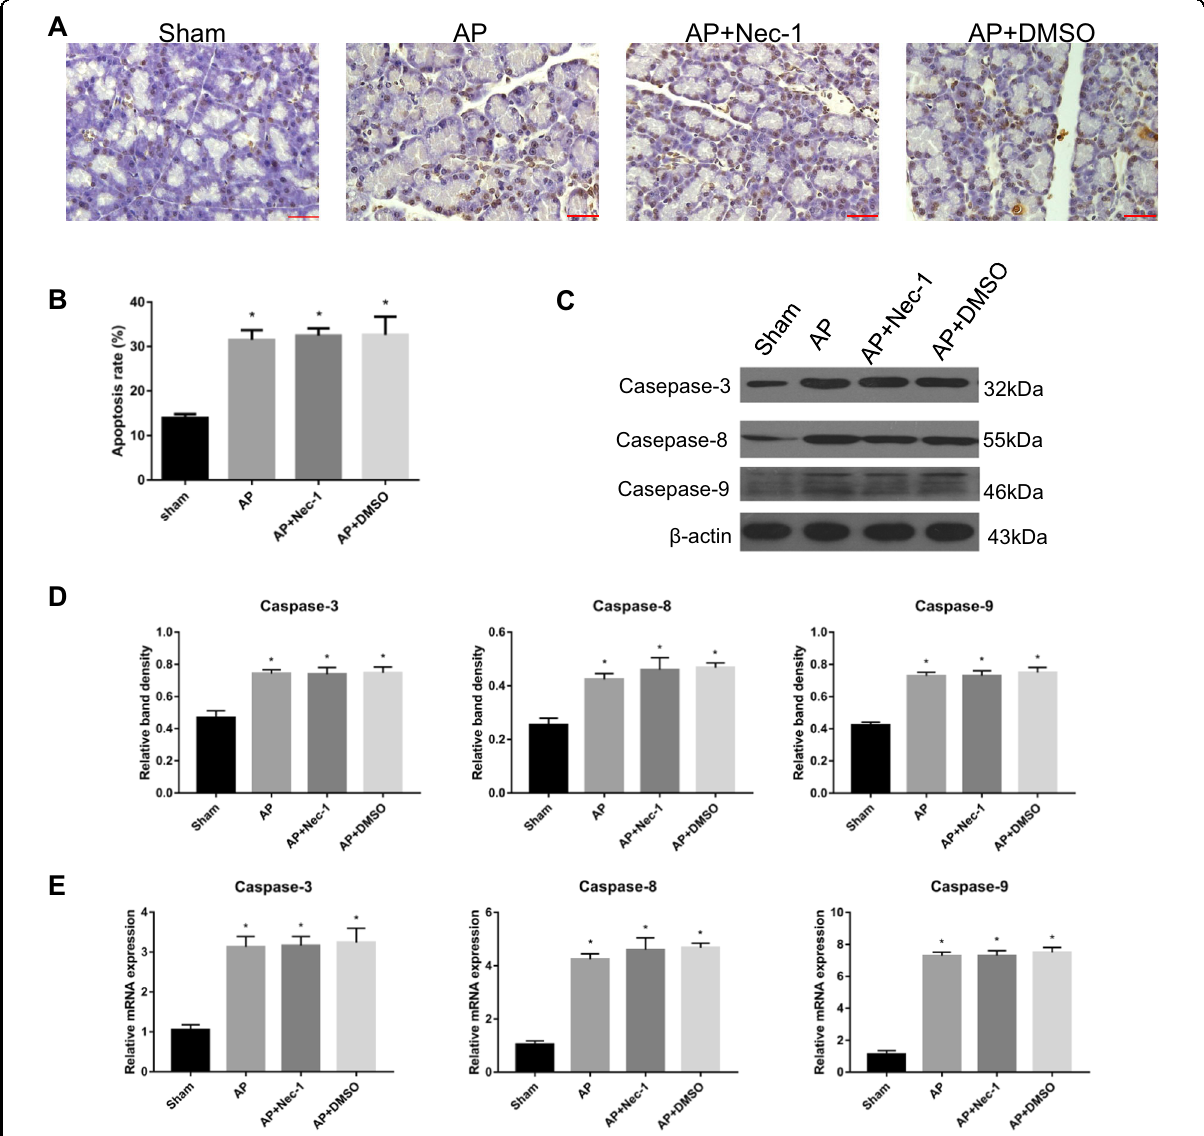
Fig. 5 Inhibition of RIPK1 during AP did not affect apoptosis in rats. a TUNEL analysis of apoptotic cells and b the apoptosis index in pancreatic tissues harvested from the rats described in Fig. 1a. c Representative immunoblot images and d quantitation of Caspase-3, Caspase-8, and Caspase-9 expression in pancreatic tissues harvested from the rats described in Fig. 1a. β -Actin was used as the protein loading control. e Relative mRNA expression of Caspase-3, Caspase-8, and Caspase-9 in pancreatic tissues harvested from the rats described in Fig. 1a. The data are the means ± S.Ds. ( n = 3). * P < 0.05 versus